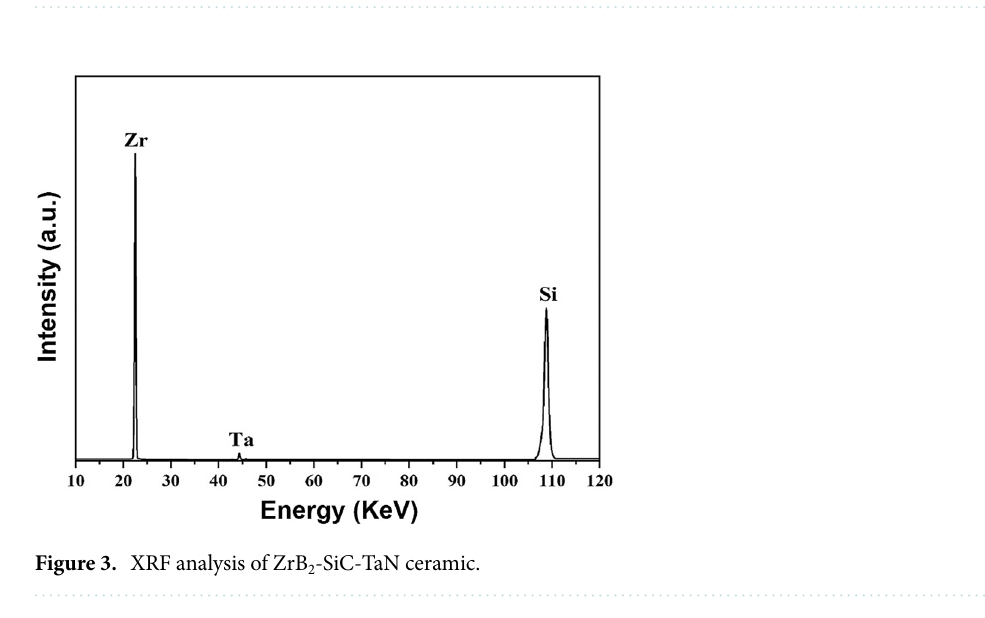
Figure 2. Temperature dependency of ΔG° Eqs. (2–5).